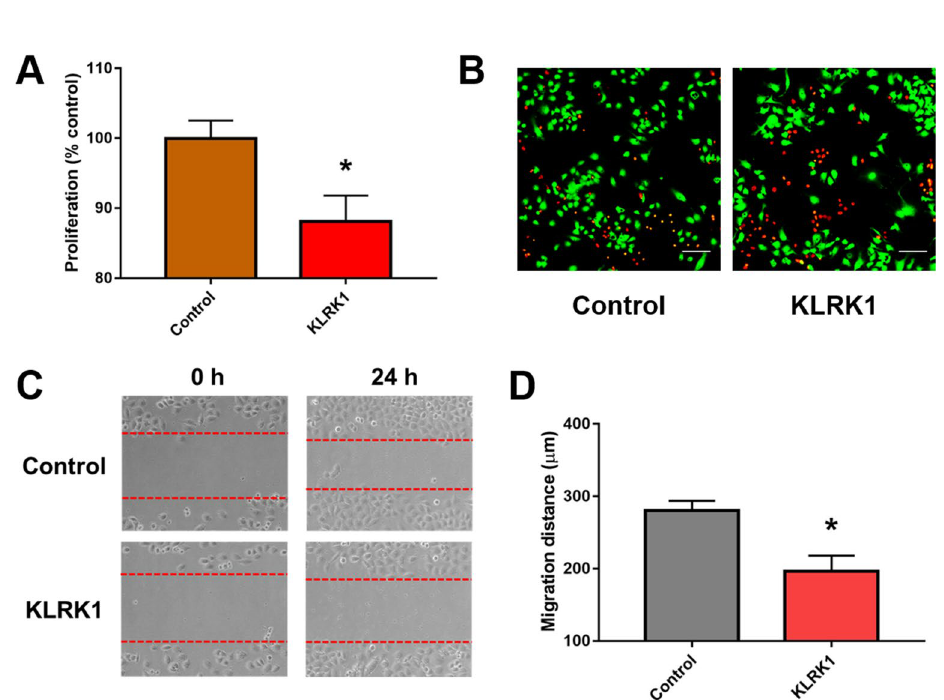
Figure 9. The effect of KLRK1 in lung cancer A549 cell lines. ( A ) The CCK-8 assay; ( B ) live/dead staining; ( C ) the migration and ( D ) migration